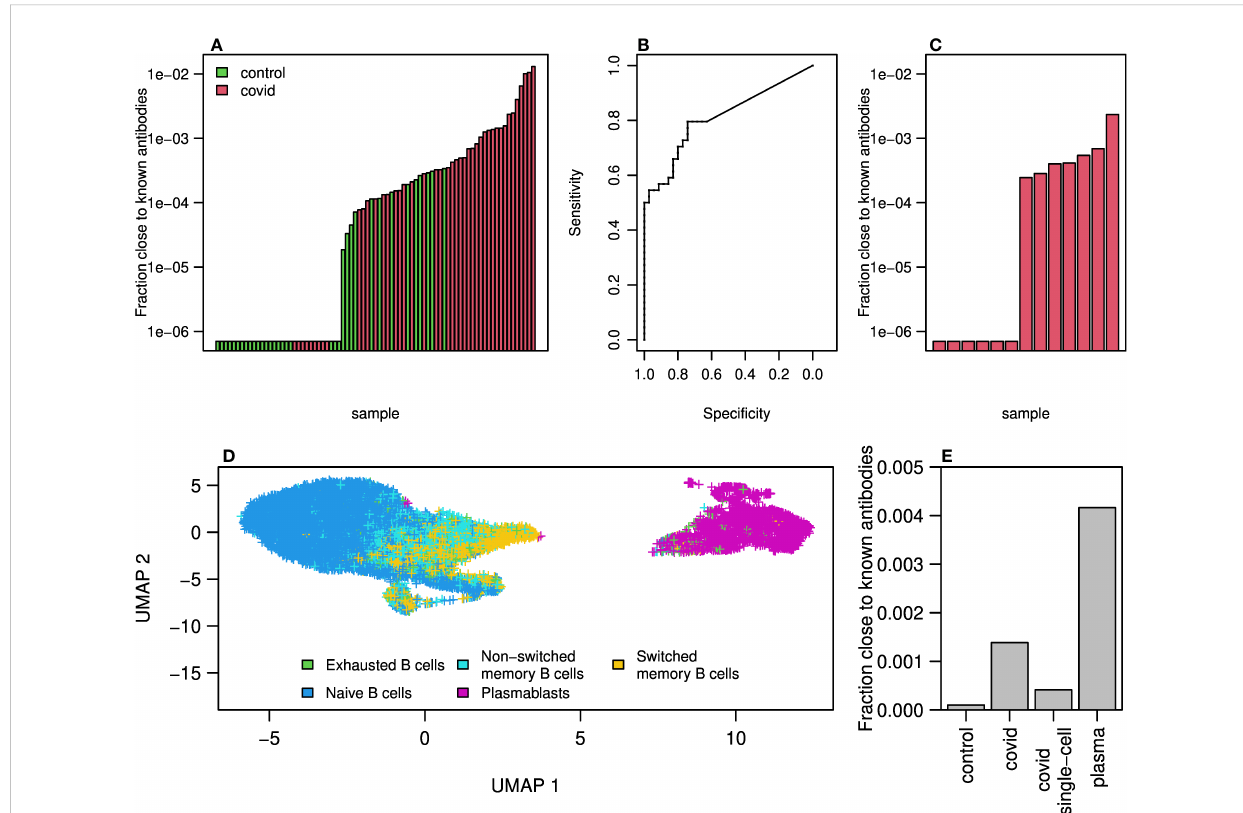
FIGURE 5 Clones of antibodies in our sequencing close to known COVID-19 antibodies from CoV-AbDab database. (A) Sum of frequencies of clones (same V and J genes and 85% similarity in AA of CDR3) close to known COVID-19 antibodies (from CoV-AbDab data base) in COVID-19 patients and controls. (B) ROC curve summarizing the results shown in (A) . (C) Sum frequencies of clones close to COVID-19 antibodies in 13 single cell COVID-19 patients data. (D) UMAP on gene expressions of B cells isolated from 13 patients showing differences between naive, memory and plasmablast cells. Cell type identi fi cation was done using SinglR. (E) Sum of frequencies of antibodies close to known COVID-19 antibodies in bulk sequencing of COVID-19 patients and control as well as in sequences from single cell sequences of COVID-19 patients and in cells identi fi ed as plasmablast